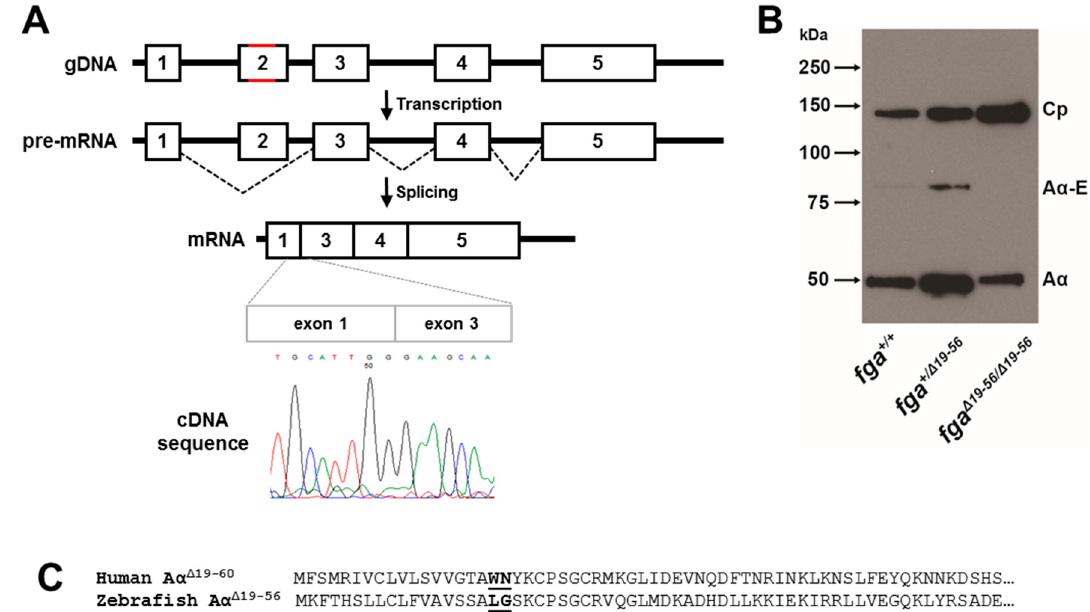
Figure 4. fga exon 2 skipping. ( A ) A scheme to highlight changes in fga exon 2 genomic DNA in red (gDNA) led to exon 2 skipping after transcription and splicing. A partial cDNA sequence to show the exon 1 to exon 3 splicing is shown. ( B ) Immunoblotting of plasma samples from fga +/+ , fga +/ Δ 19 − 56 , and fga Δ 19 − 56/ Δ 19 − 56 fish with anti-ceruloplasmin and anti-fibrinogen A α chain antibodies. ( C ) Amino acid alignment of the predicted fibrinogen A α chains resulting from the human FGA IVS2+3insCAT mutation and the zebrafish fga Δ 19 − 56 mRNA. The junction of exon 1- and exon 3-encoded amino acids are in bold and underlined for each chain.